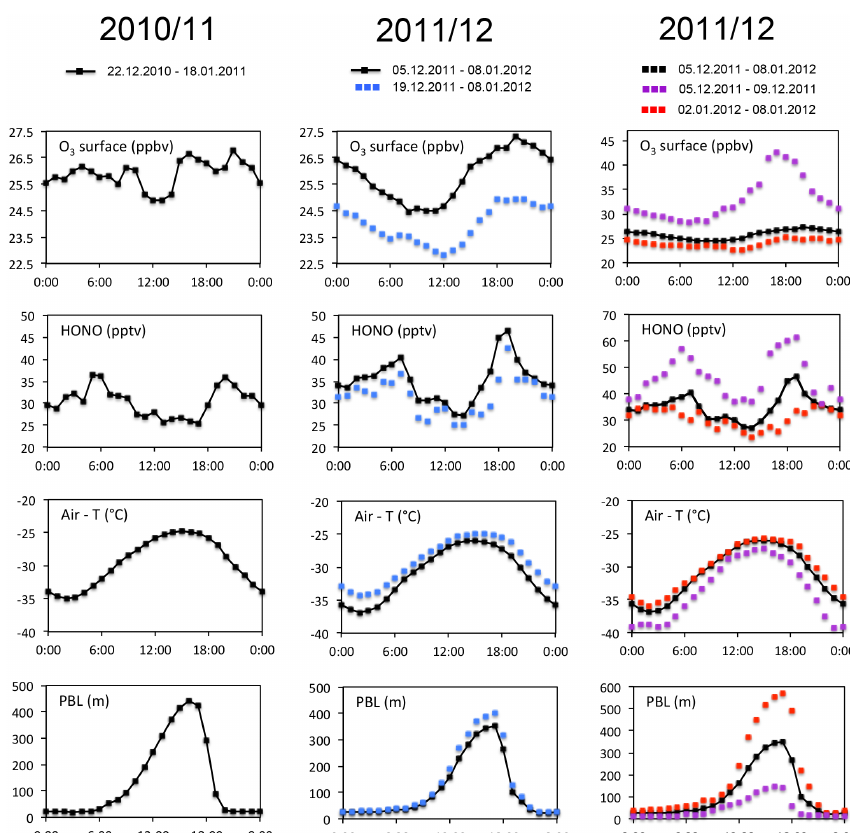
Figure 3. Left and middle: from top to bottom, diurnal changes of surface ozone mixing ratio, HONO mixing ratio, air temperature, and PBL height simulated by the MAR model (see Sect. 5) at Concordia over the entire period of measurements in 2010/2011 (left) and 2011/20112 (middle) (black dots). The blue dots reported for the 2011/2012 summer correspond to the period between 19 December 2011 and 8 January 2012. Right: Same as left and middle but for the entire 2011/2012 period (black dots), at the beginning (early December, violet dots), and the end (red dots) of the period. Note the use of different vertical scales for right compared to left and middle